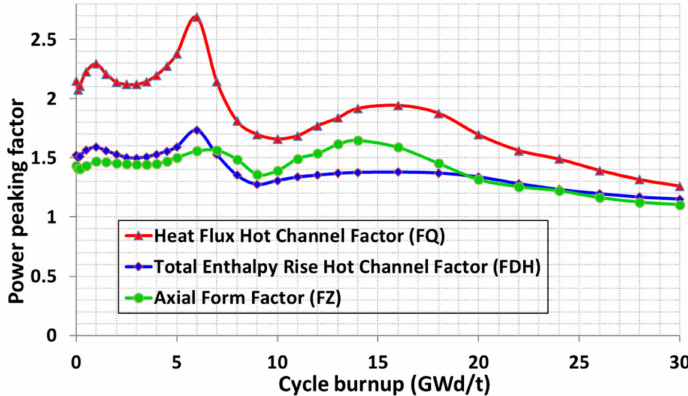
Figure 14. Simulated EPR full-core power peaking factors versus burnup (cycle 1, RCCA out, modelled in 21 axial layers, incorporating spatial burnup and thermal-hydraulic conditions) using